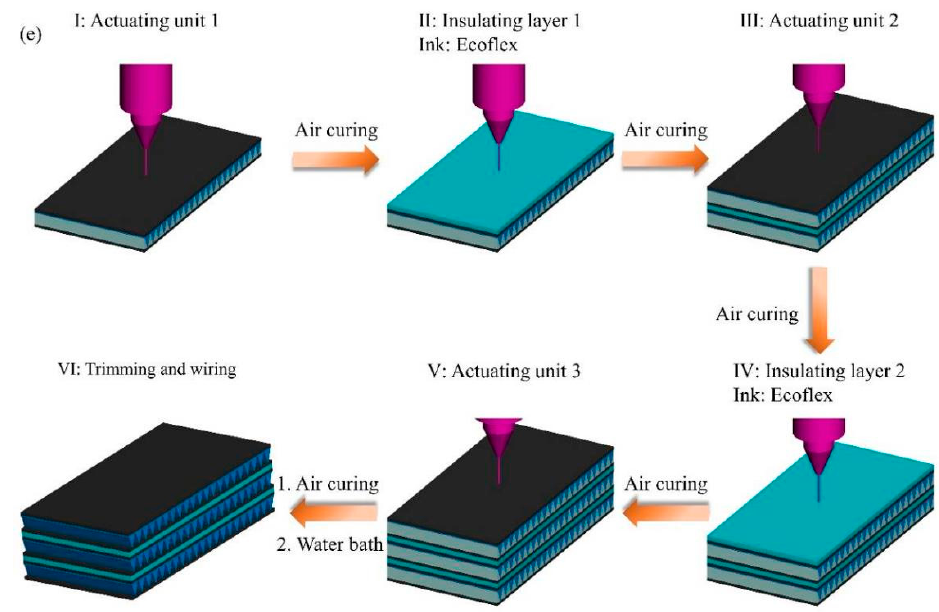
Figure 7. Printing process and printed structures. ( a ) Finished corrugated PVC gel core layer. ( b ) Designed shape of the corrugation in core layers. ( c ) Finished CNT/SMP composite electrode layer. ( d ) Printing process of a single layer PVC gel actuator. ( e ) Printing process of a multilayer PVC gel actuator.